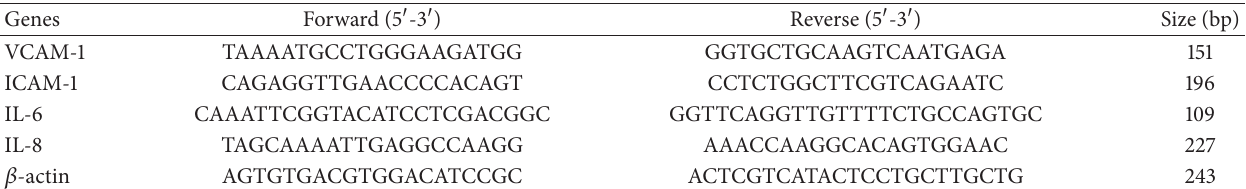
Table 1: Primers used for real-time PCR and the size of